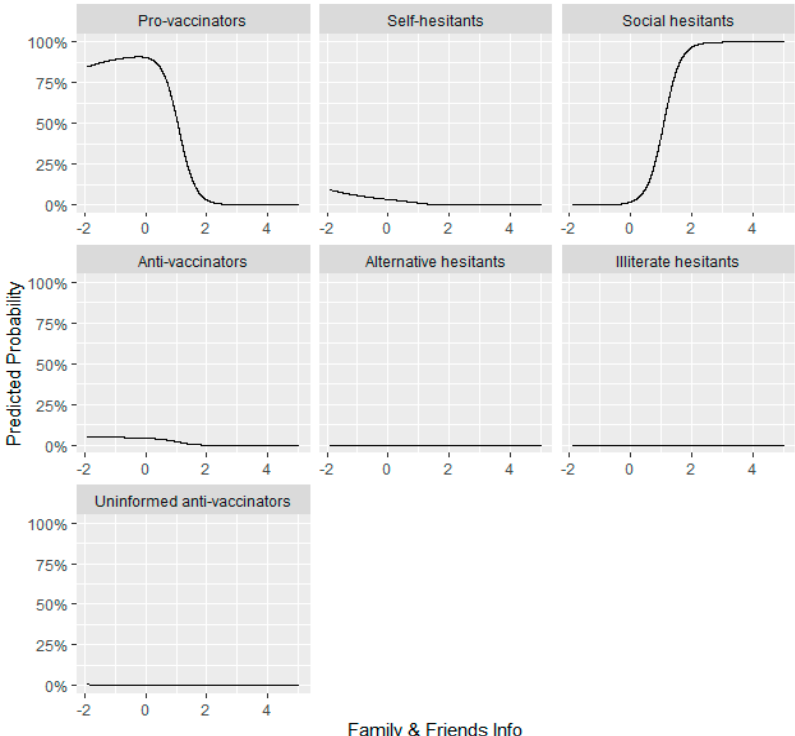
Figure A11. Marginal Effects Multinomial Logistic Regression. Family and Friends Info.